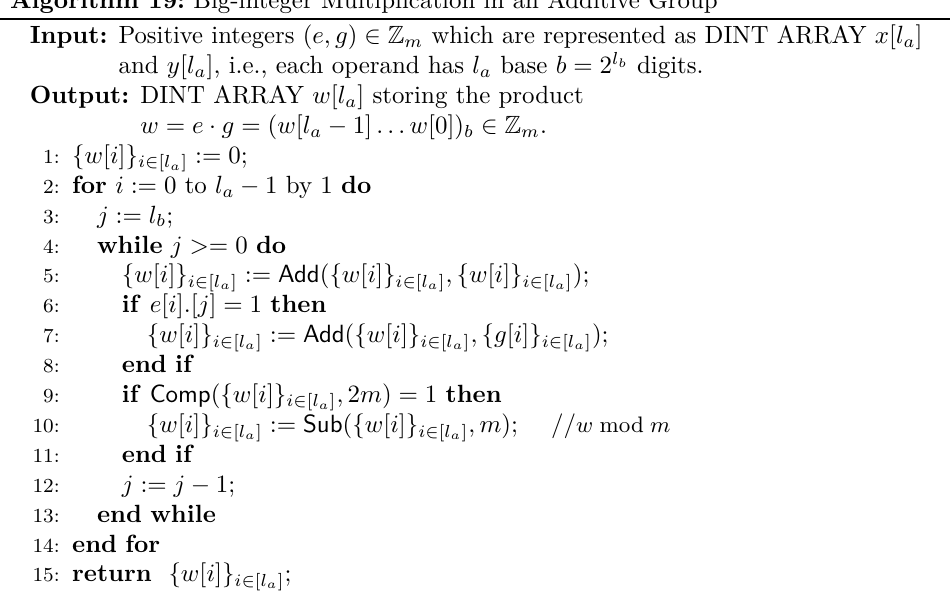
Algorithm 19: Big-integer Multiplication in an Additive